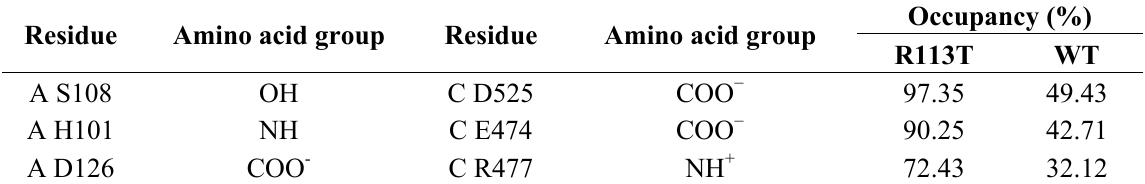
Table 3. Hydrogen bond (salt bridge) contacts between the WT PH1704 and the R113T mutant during the MD